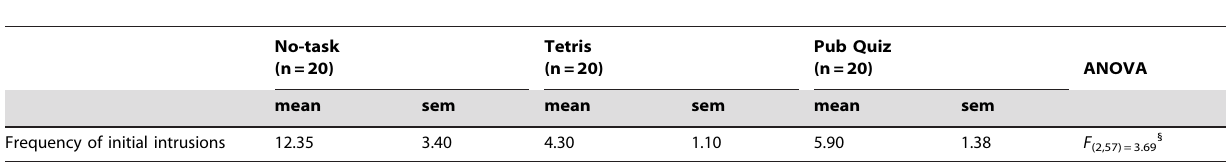
Table 3. Experiment 1 frequency of initial intrusions during the 10-min experimental manipulation [i.e. during computer game play or no-task